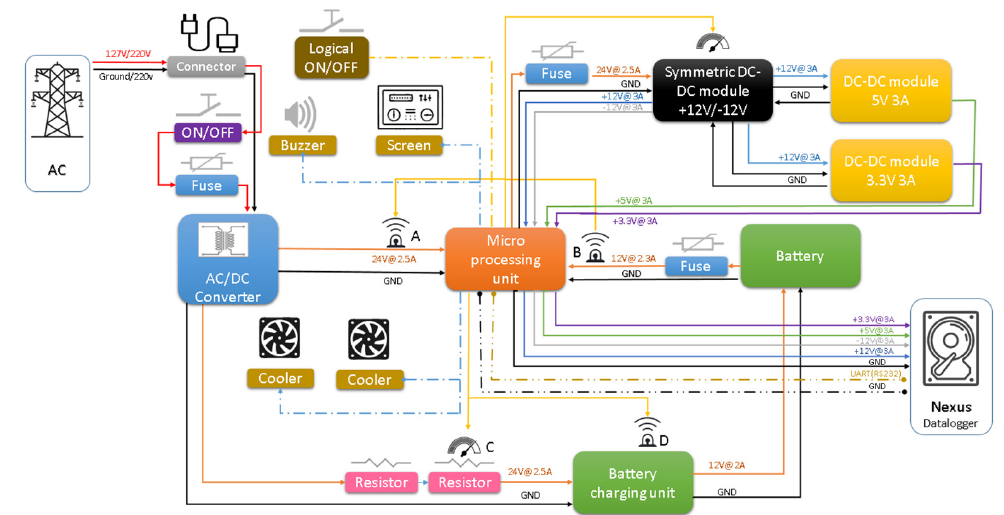
Figure 1. Block diagram of the internal circuits of the power supply.